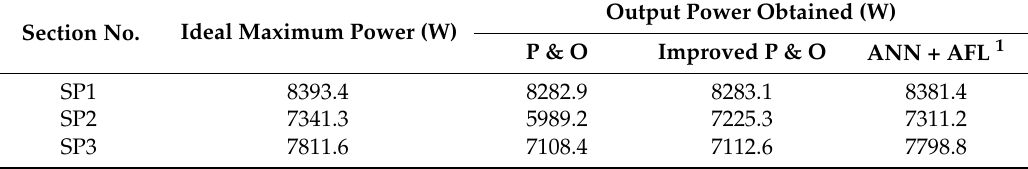
Table 3. Performances of the different MPPT (maximum power point tracking) methods under different